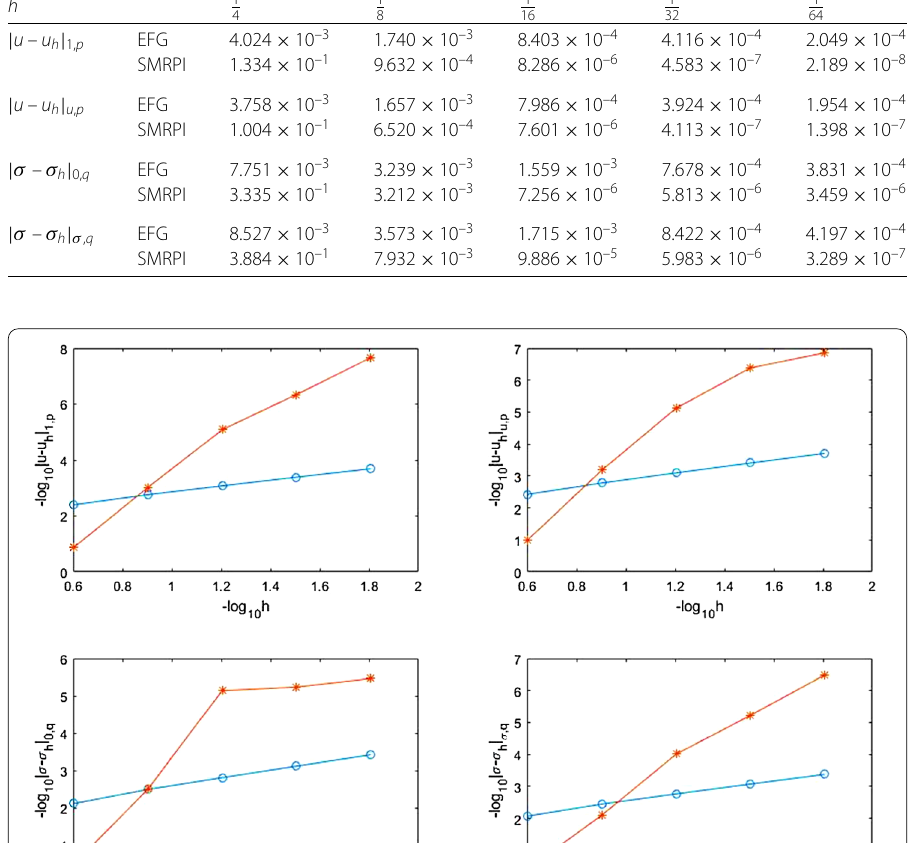
1 1 1 4 8 16 32